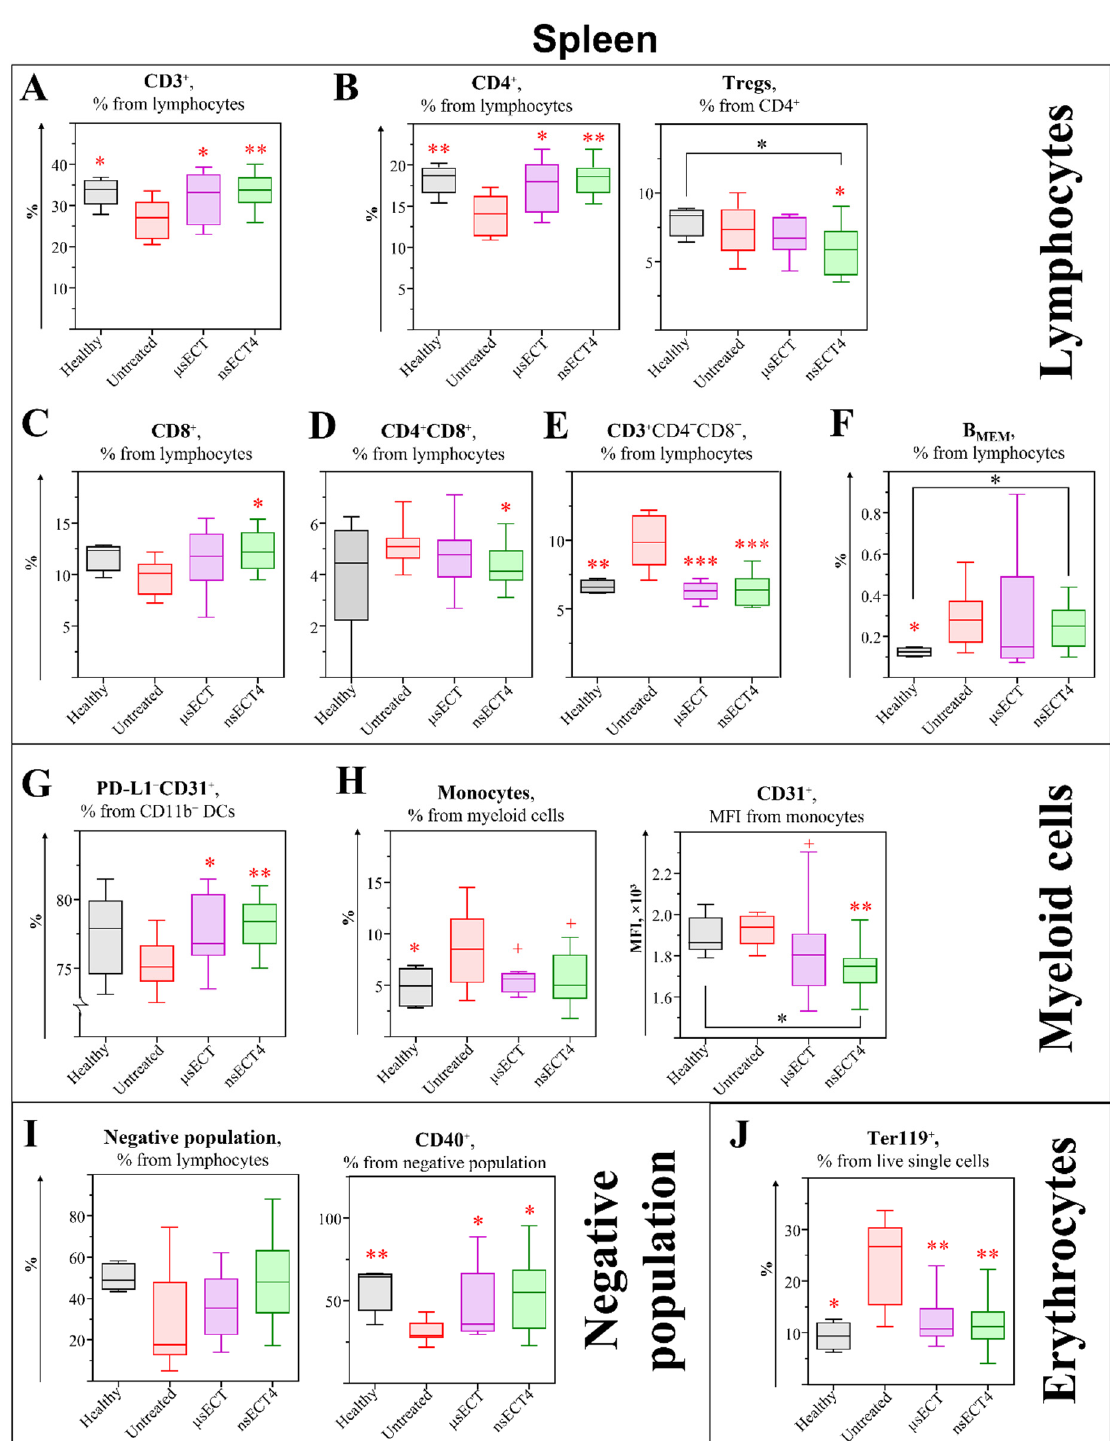
Figure 4. Time-independent study. Lymphocytes ( A – F ), myeloid cells ( G , H ), “Negative” (Lin − ) population ( I ) and erythrocytes ( J ) in mice spleens. Cytometry was performed with BD FACSAria III cytometer. Statistically significant (* p < 0.05; ** p < 0.005) differences and tendencies (+ p = 0.05–0.1) compared to the untreated group.